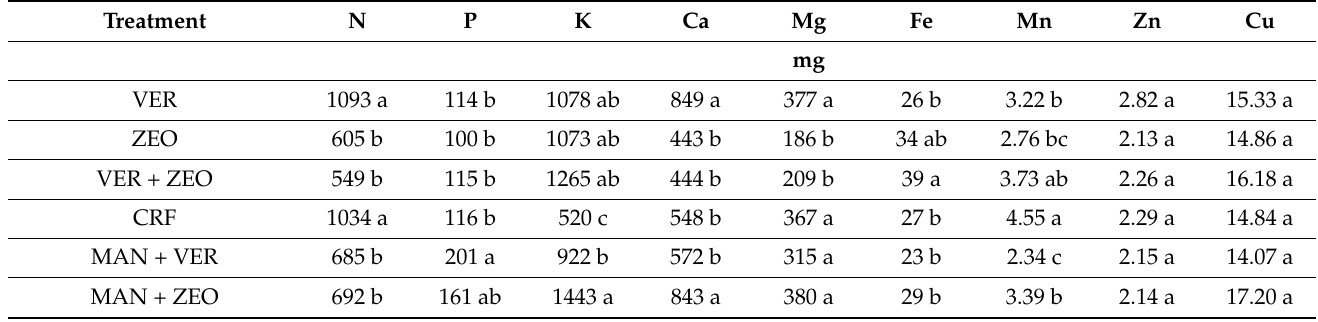
Table 4. Total plant nutrient content for pepper plants among the